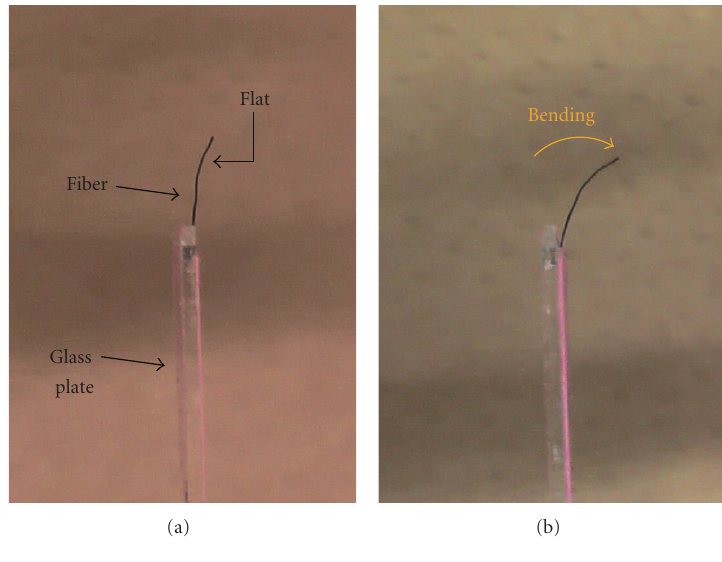
Figure 2: Photos of PAA/MB fiber at humidities of (a) 90% and (b) 30%.